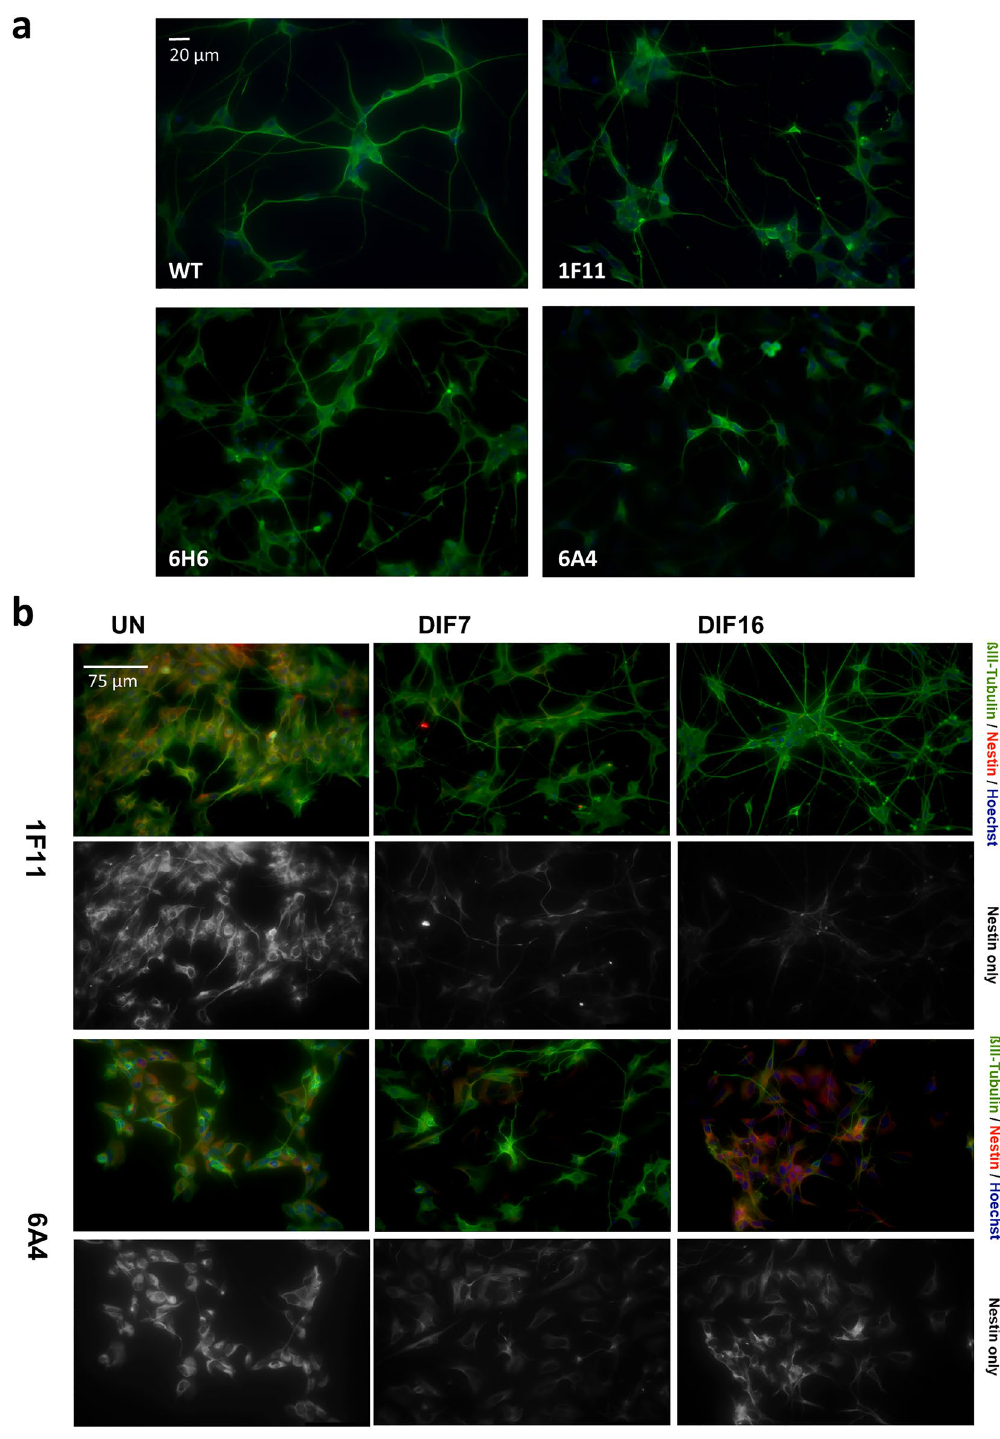
Figure 5. Immunofluorescence microscopy of SHANK2 mutant cells. ( a ) β3-Tubulin expression after 7 days of differentiation (DIF7) illustrating the morphology of control and SHANK2 mutant cell lines. ( b ) Nestin and β3-Tubulin co-staining using immunofluorescence microscopy. During 16 days of neuronal differentiation, the number of cells showing Nestin expression decreased in the control line (1F11), and nearly all cells developed neuronal morphology. In comparison, cells expressing Nestin could be detected throughout the differentiation period in the genome edited cell line (6A4). UN undifferentiated, DIF7 7 days of differentiation, DIF16 16 days of